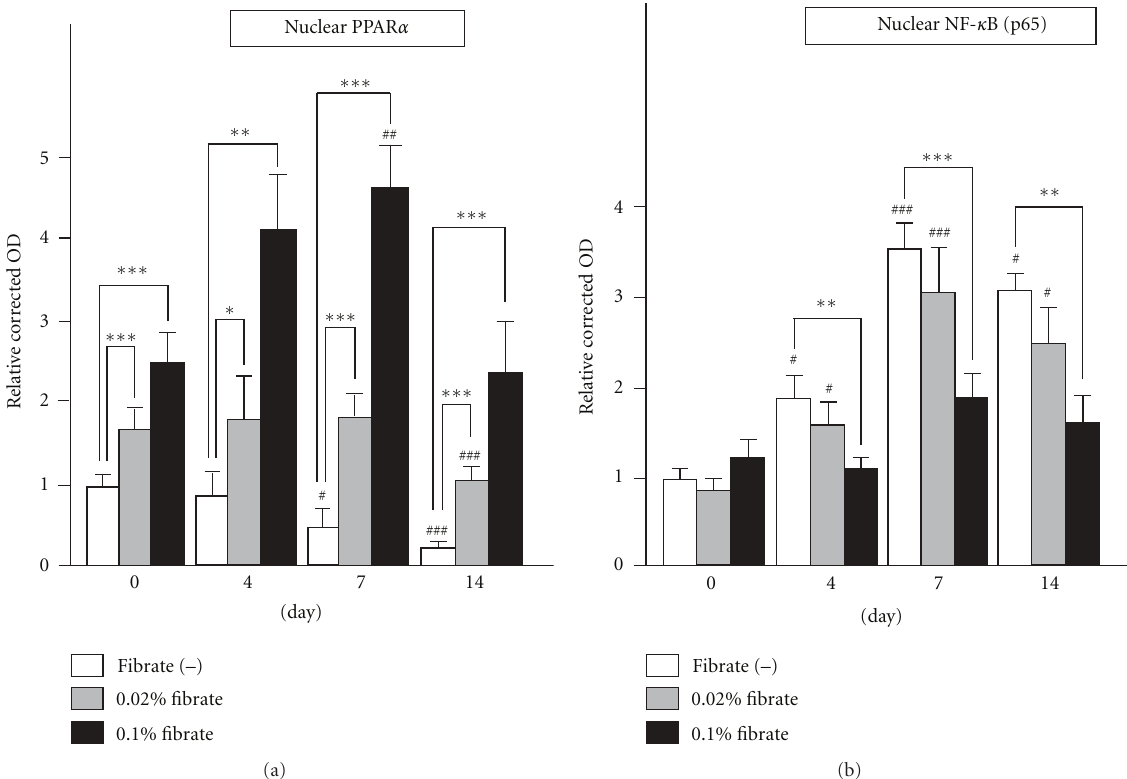
Figure 3: Alteration of intranuclear transcription factor activities. (a) The PPAR response element-binding activities of intranuclear PPAR α from glomeruli in each group of anti-Thy1 nephritis rats. (b) The NF- κ B response element-binding activities of intranuclear NF- κ B in each group. For these assays, the nuclear protein samples were subjected to ELISA in triplicate. The optical density (OD) for each sample was corrected by that of a blank sample and by protein amount in each sample. The data were expressed as changes relative to the value for the control rats (Fib( − ) group of rats at day 0). Values are means ± SD. Significant di ff erences from the respective day 0 groups are indicated with number signs ( # P < 0 . 05, ## P < 0 . 01, ### P < 0 . 001), while significant di ff erences between regular-diet and clofibrate-diet groups are indicated with asterisks ( ∗ P < 0 . 05, ∗∗ P < 0 . 01, ∗∗∗ P < 0 .